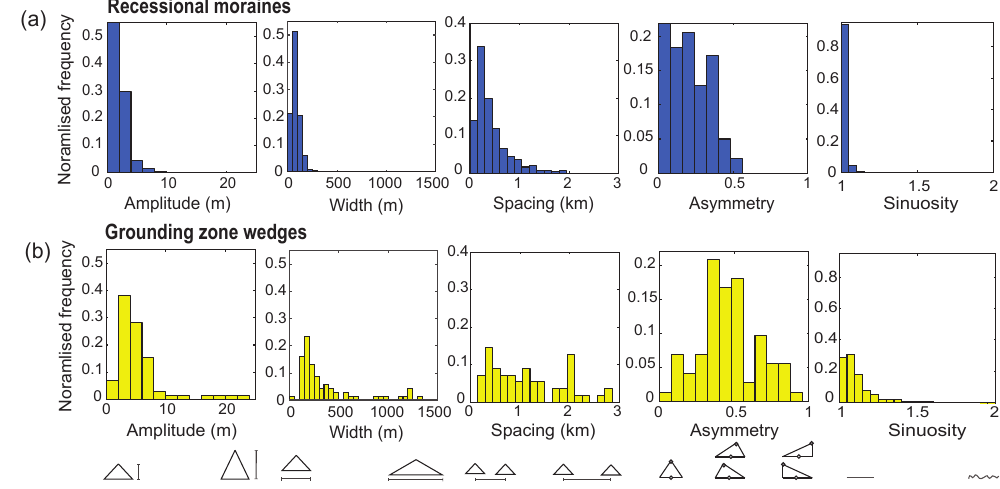
Figure 4. Normalised frequency distribution of morphometric parameters for the population of western Ross Sea recessional moraines ( n = 4586) and grounding zone wedges ( n = 1689). Amplitude is equivalent to maximum landform height, width represents distance in the along-flow direction, spacing was measured as the distance in between landform peaks in a retreat sequence, asymmetry was measured based on the position of landform peak relative to the landform width midpoint, and sinuosity was measured across the entire mappable length of individual